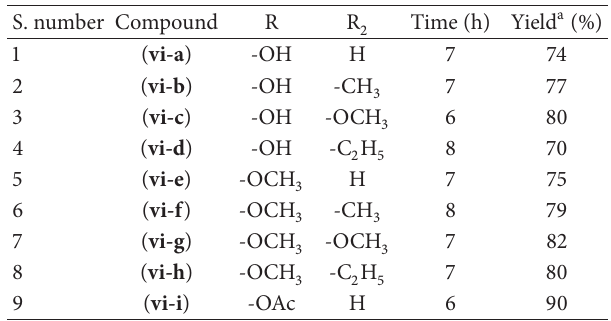
Table 2: Derivatives of 4-aryl-3-phenyl-coumarin-2-one and their yield (%) for Scheme